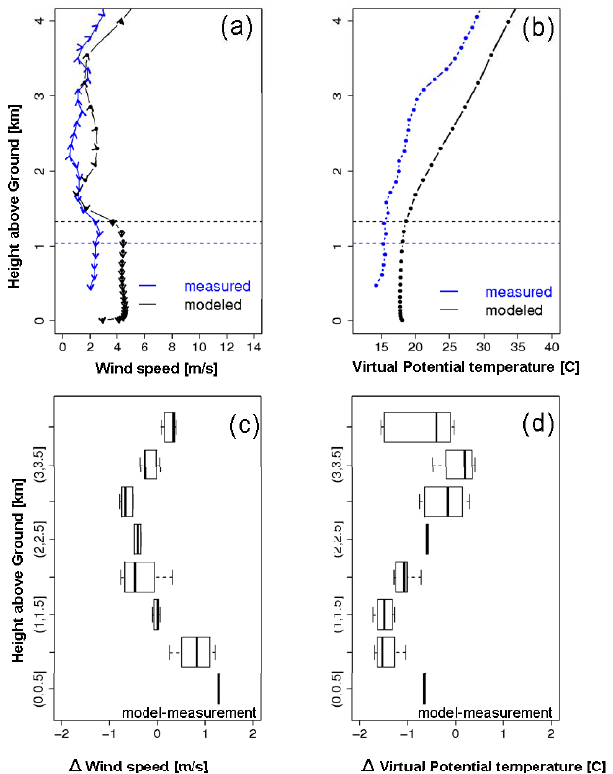
Figure 2. (a-b) Profiles of observed vs. modeled wind fields and virtual potential temperature for 3 rd August 2006 at 15 UTC. The horizontal direction of wind is indicated with arrowheads. The dashed horizontal lines represent both observed (in blue) and simulated (in black) mixing heights calculated using bulk Richardson method. (c-d) the model-measurement mismatch for the monthly averages of these fields at 15 UTC, plotted against different altitude bins. The box indicates 95% quartile, the whisker denotes minimum and maximum of deviations and the vertical bar inside the box denotes the median.